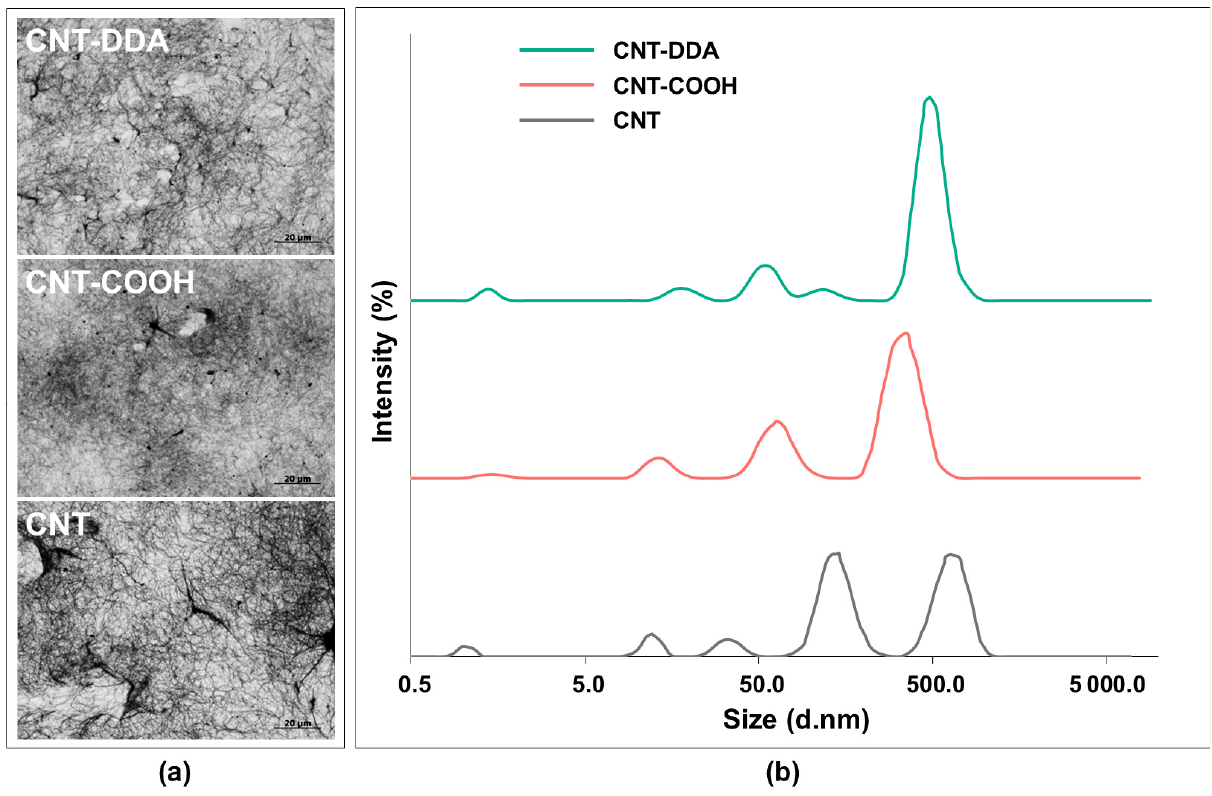
Figure 2. ( a ) Optical images of dispersion droplets on glass at 1000× magnification and ( b ) DLS- curves of dispersions obtained by ultrasonic disintegration of CNTs in